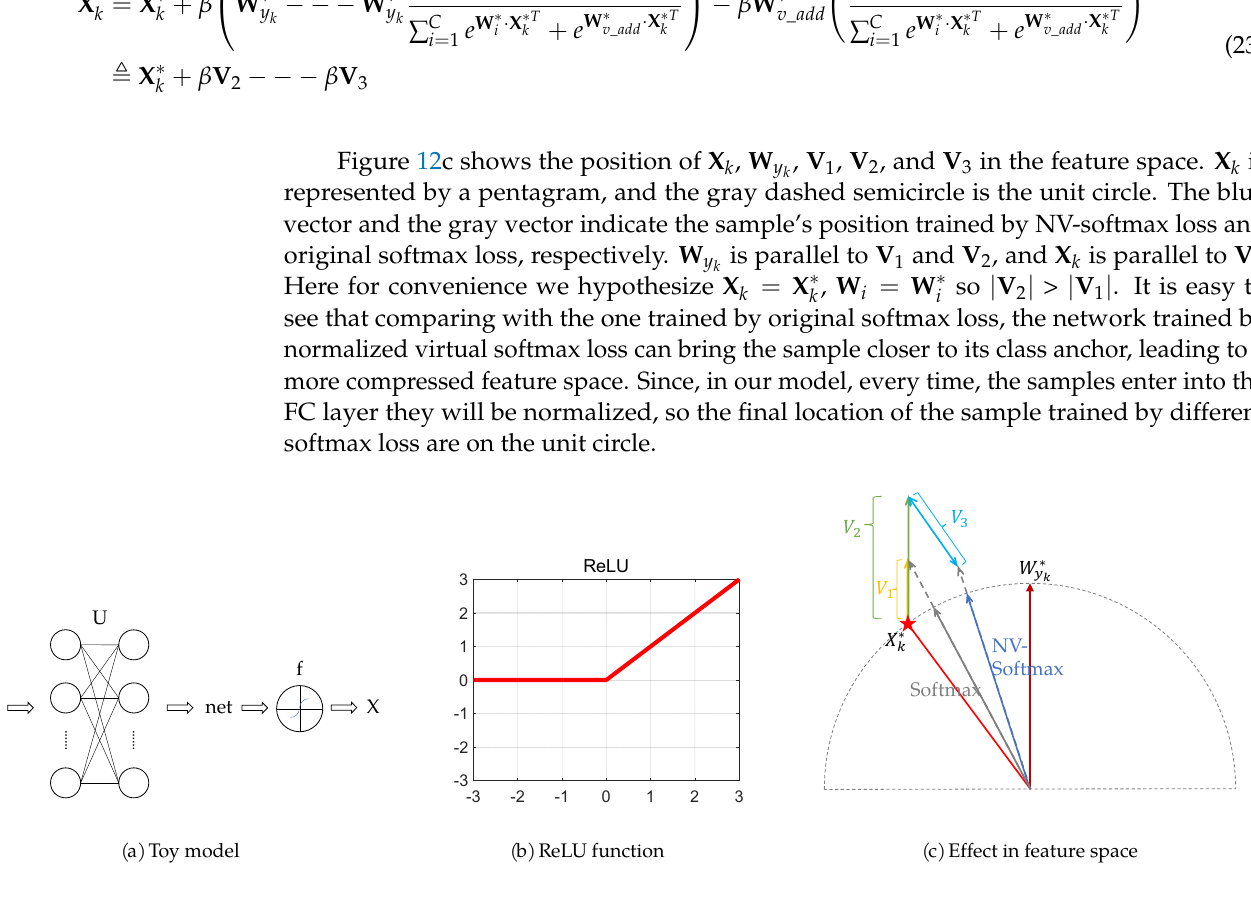
Figure 12. ( a ) The toy model . ( b ) The ReLU function. ( c ) The comparison between softmax and